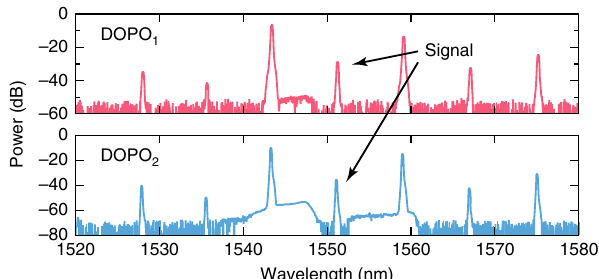
Fig. 3 Optical spectra of two DOPO signals. The measured spectra of the primary DOPO (top, DOPO 1 ) and the secondary DOPO (bottom, DOPO 2